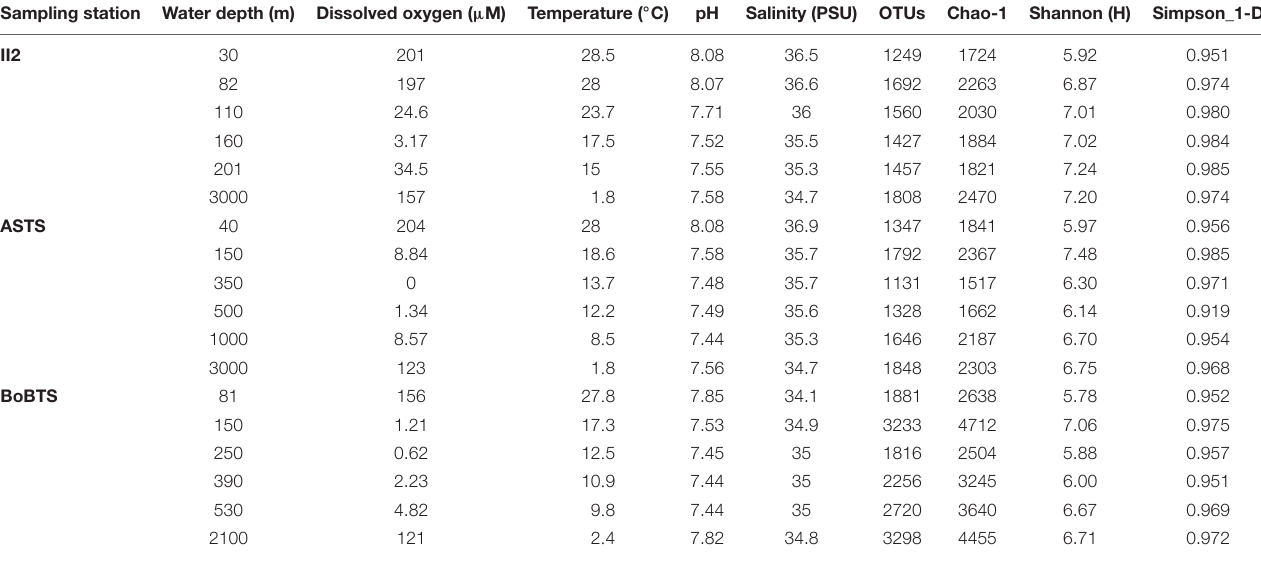
TABLE 1 | Tabulation of data on physical factors along with prokaryotic diversity estimates (at 97% similarity) for water collected from II2, ASTS, and BoBTS using